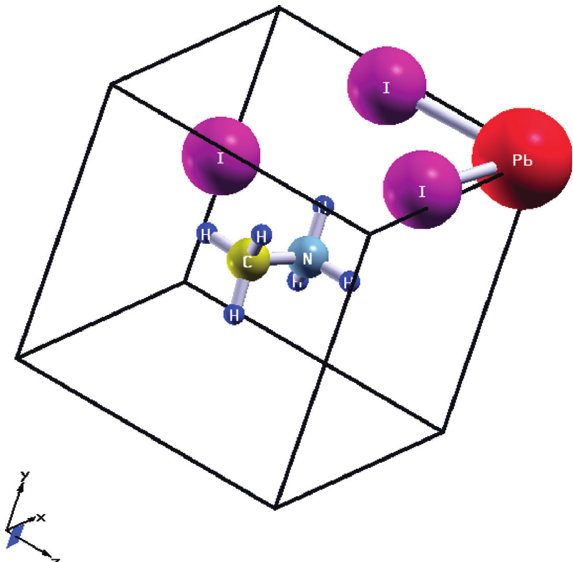
Figure 1: Crystal structure of CH